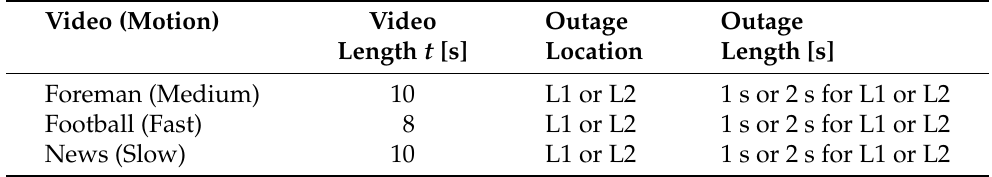
Figure 4. Network outage location in the video. Table 2. Video used for subjective